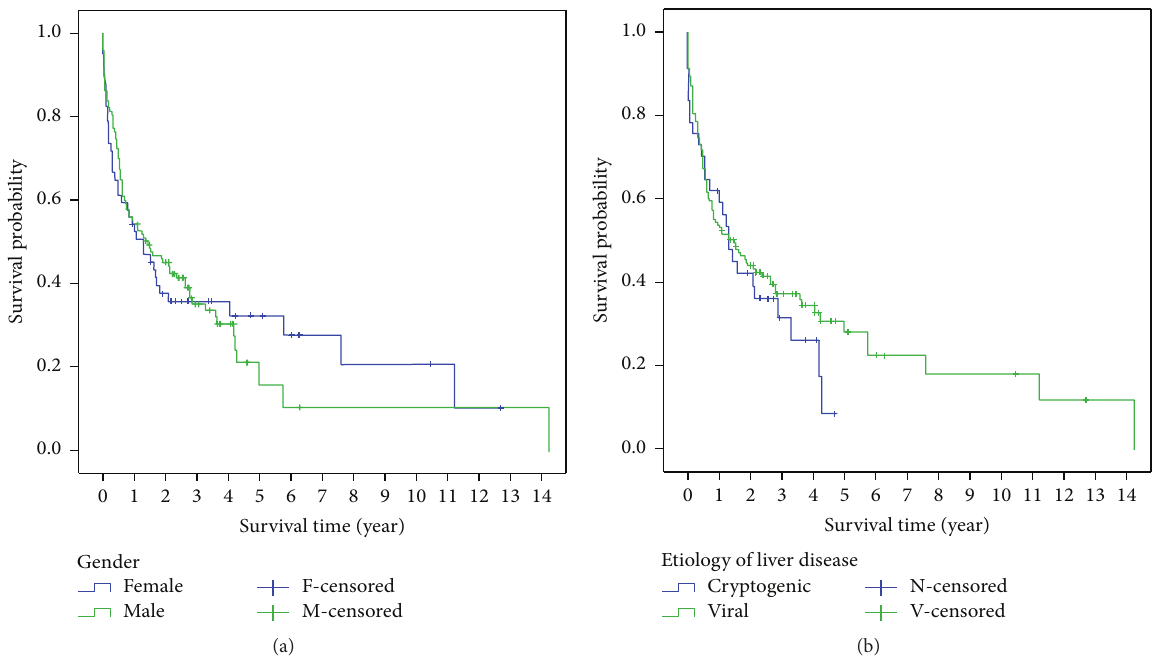
Figure 1: (a) Cumulative survival rate in patients with hepatocellular carcinoma by gender. (b) Cumulative survival rate in patients with hepatocellular carcinoma by etiology of liver disease.